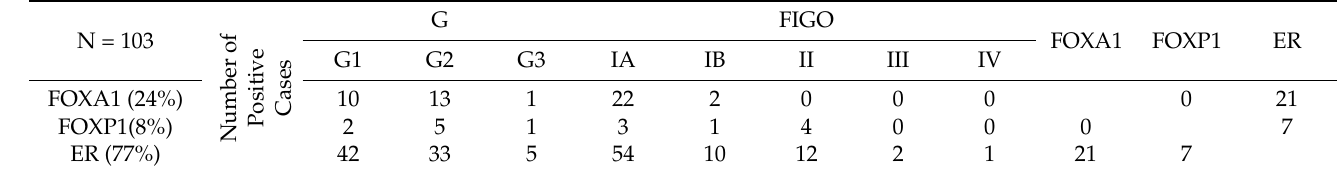
Table 2. Expression of targeting proteins according to grade and stage.